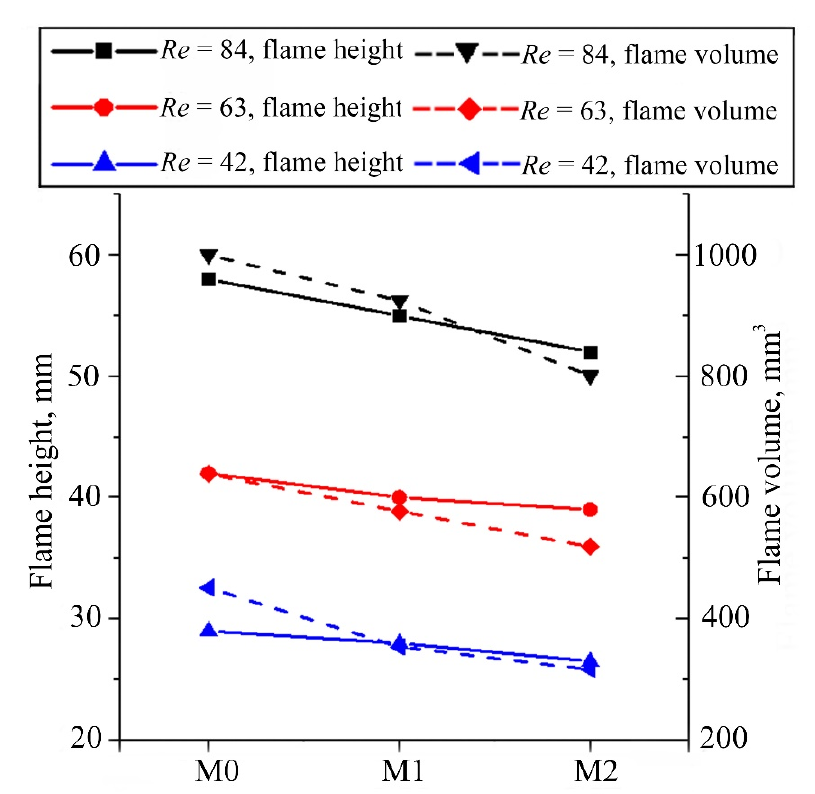
Figure 5. Effects of different gradient strengths of magnetic fields on height and volume of diffu- sion flames.